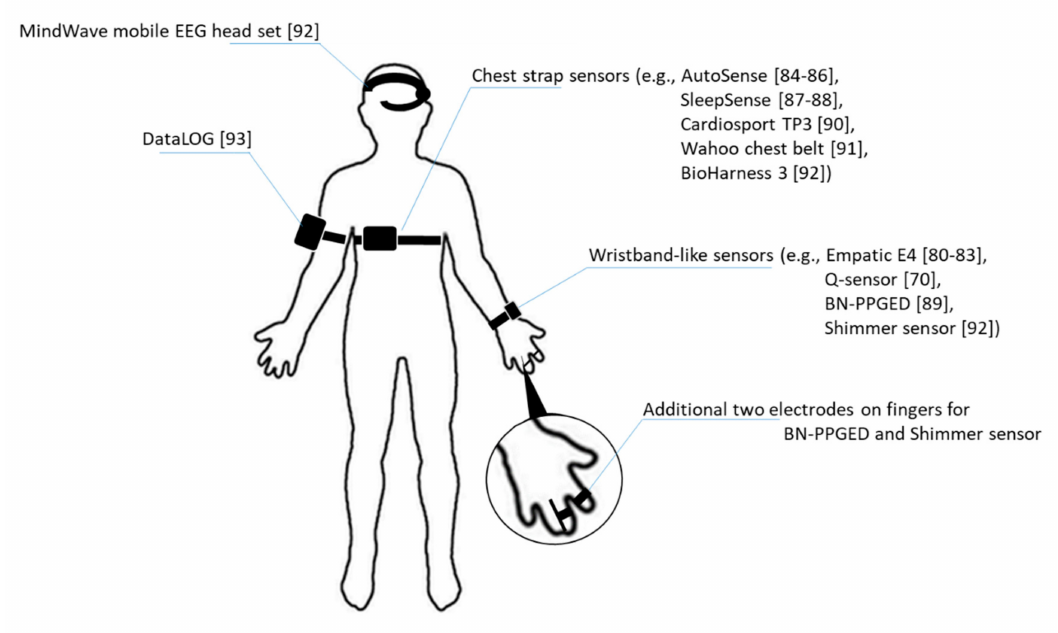
Figure 1. Illustration of sensors placement on human